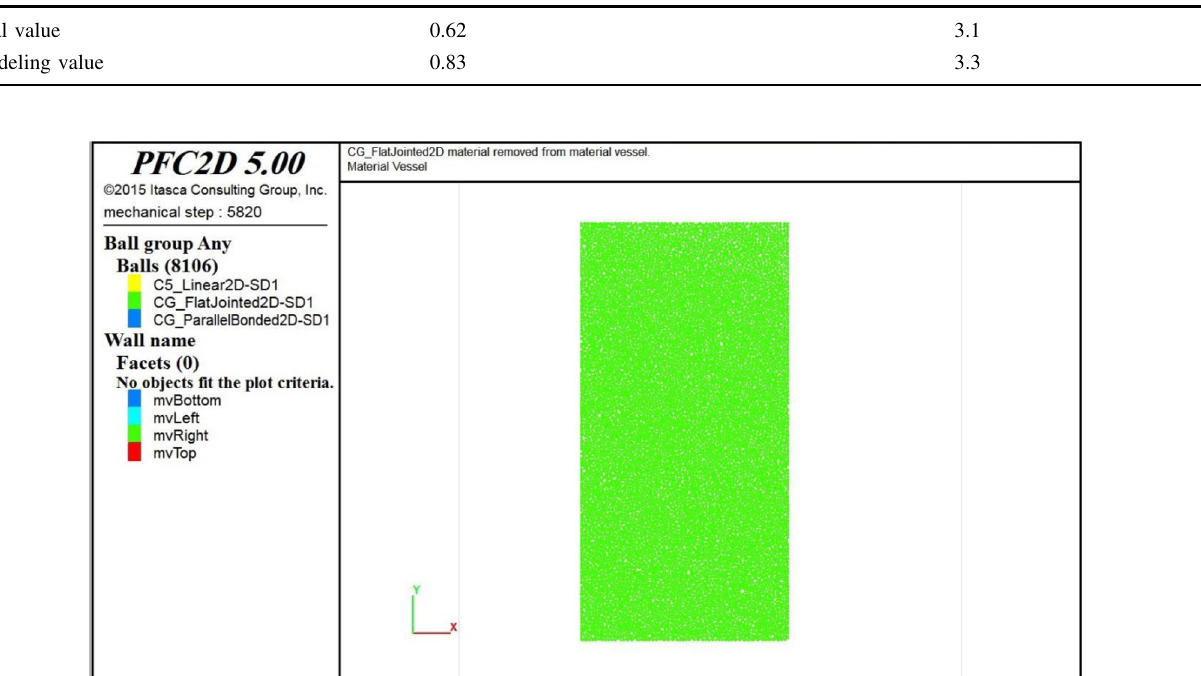
Fig. 6 Numerical model for Shearer test